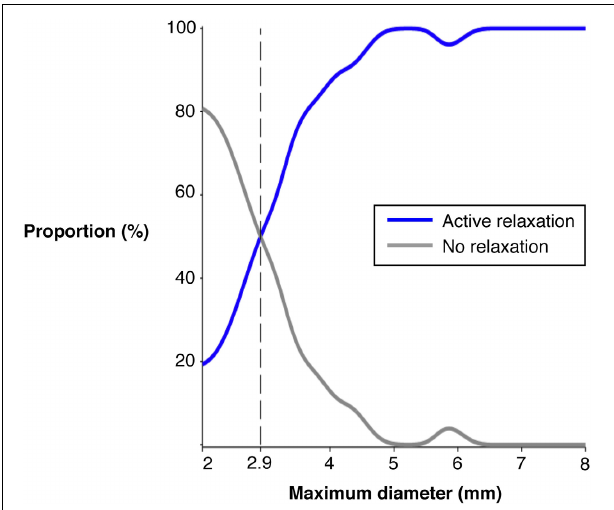
FIGURE 12 | The proportion of fast ( > 7mm/s) moving boluses associated with active inhibition at the anal end of the bolus. The maximal diameter size refers to the increase above the minimum occluded diameter and this was calculated at each frame during the movement of the bolus. As the diameter increases the proportion of boluses associated with active relaxation increase. Once the diameter exceeds 5mm above the minimum occluded diameter nearly all boluses are associated with active